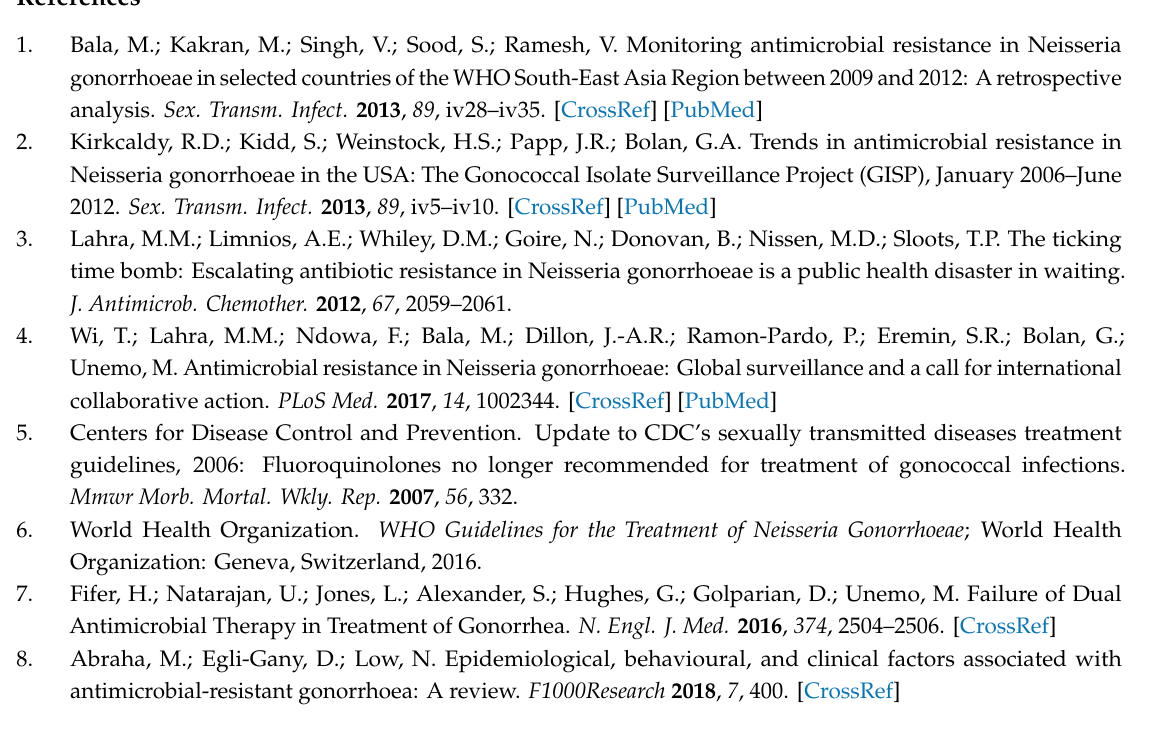
Figure S1: Meta-regression plots showing the weighted average proportion of isolates that were penicillinase producing N. gonorrhoeae (PPNG) over time in Australia, Australian states and territories and New Zealand, Figure S2: Meta-regression plots showing the weighted average proportion of isolates that demonstrated chromosomally mediated resistance (CMRP) over time in Australia, Australian states and territories and New Zealand, Table S1: Summary of the data extracted on the number of isolates tested, number of isolates susceptible, having decreased susceptibility and resistance from each study that was included in the meta-analysis, Table S2: Proportion of N. gonorrhoea isolates susceptible, decreased susceptible and resistant to various antimicrobials and the Odds ratio for changes in rates in Australia, Australian states and territories and New Zealand over